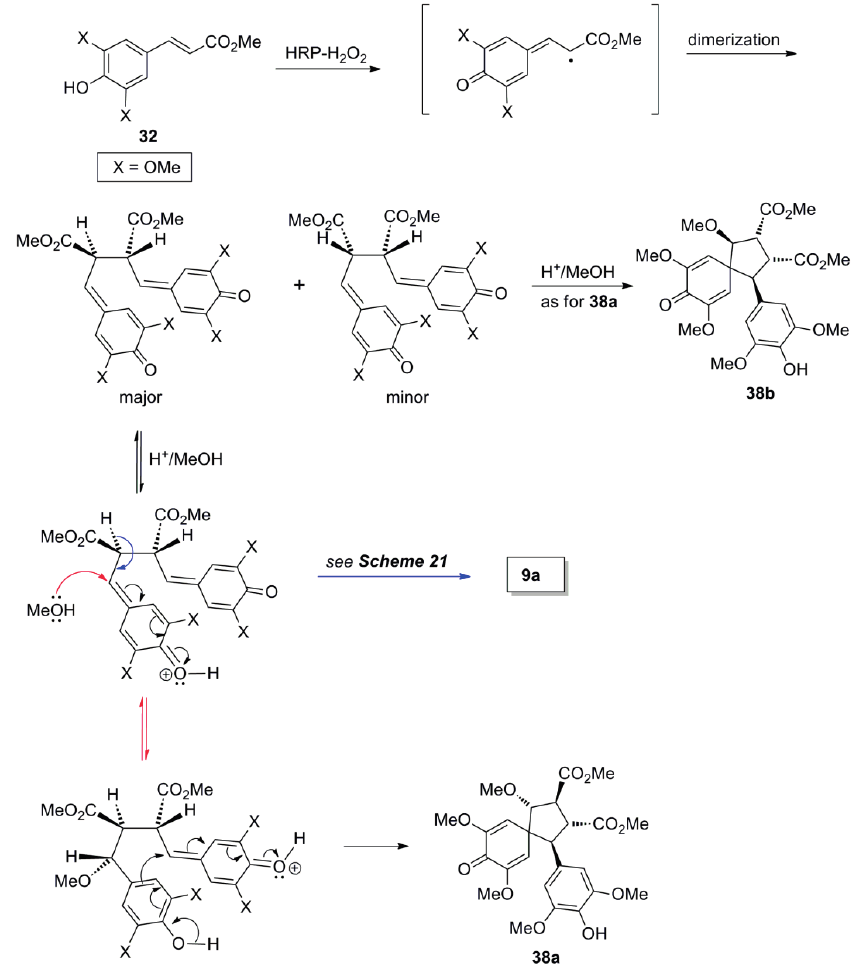
Scheme 24. Outline of the plausible mechanisms for the formation of products 9a and 38a , b .